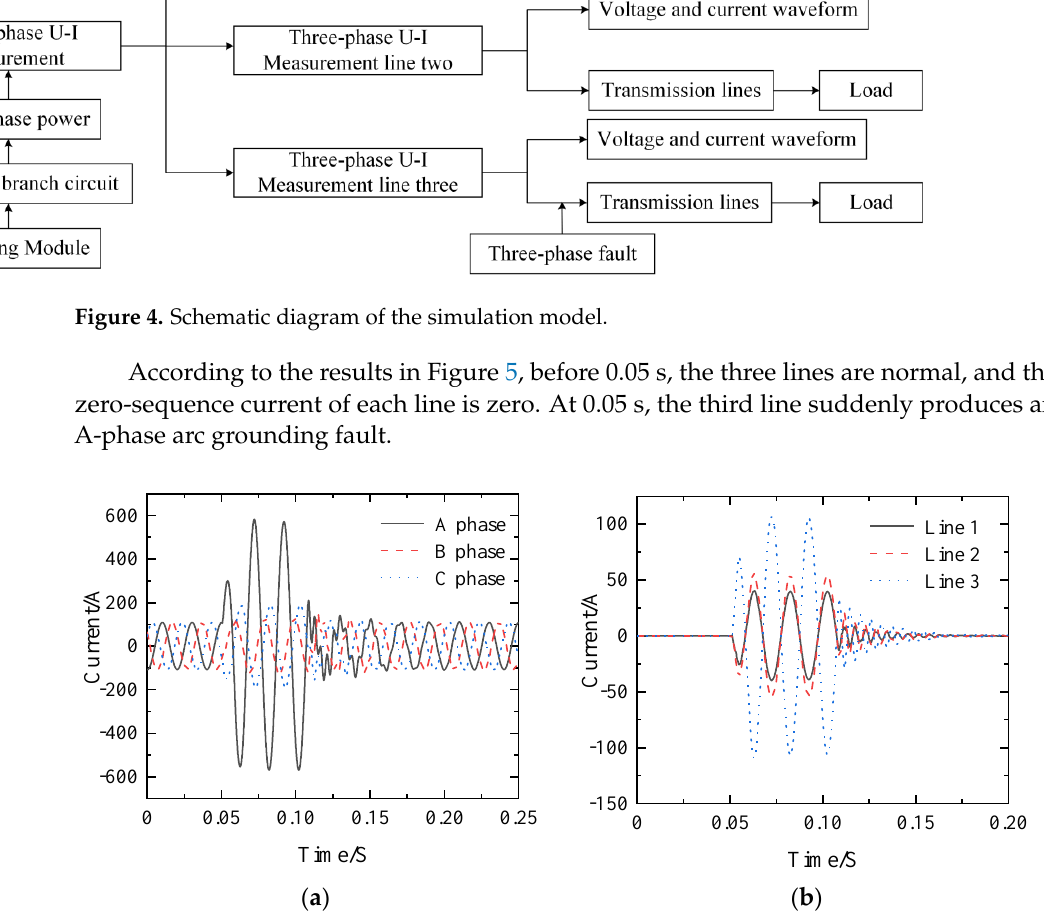
Figure 5. ( a ) Three-phase current of the faulty line. ( b ) Zero sequence current of three lines.